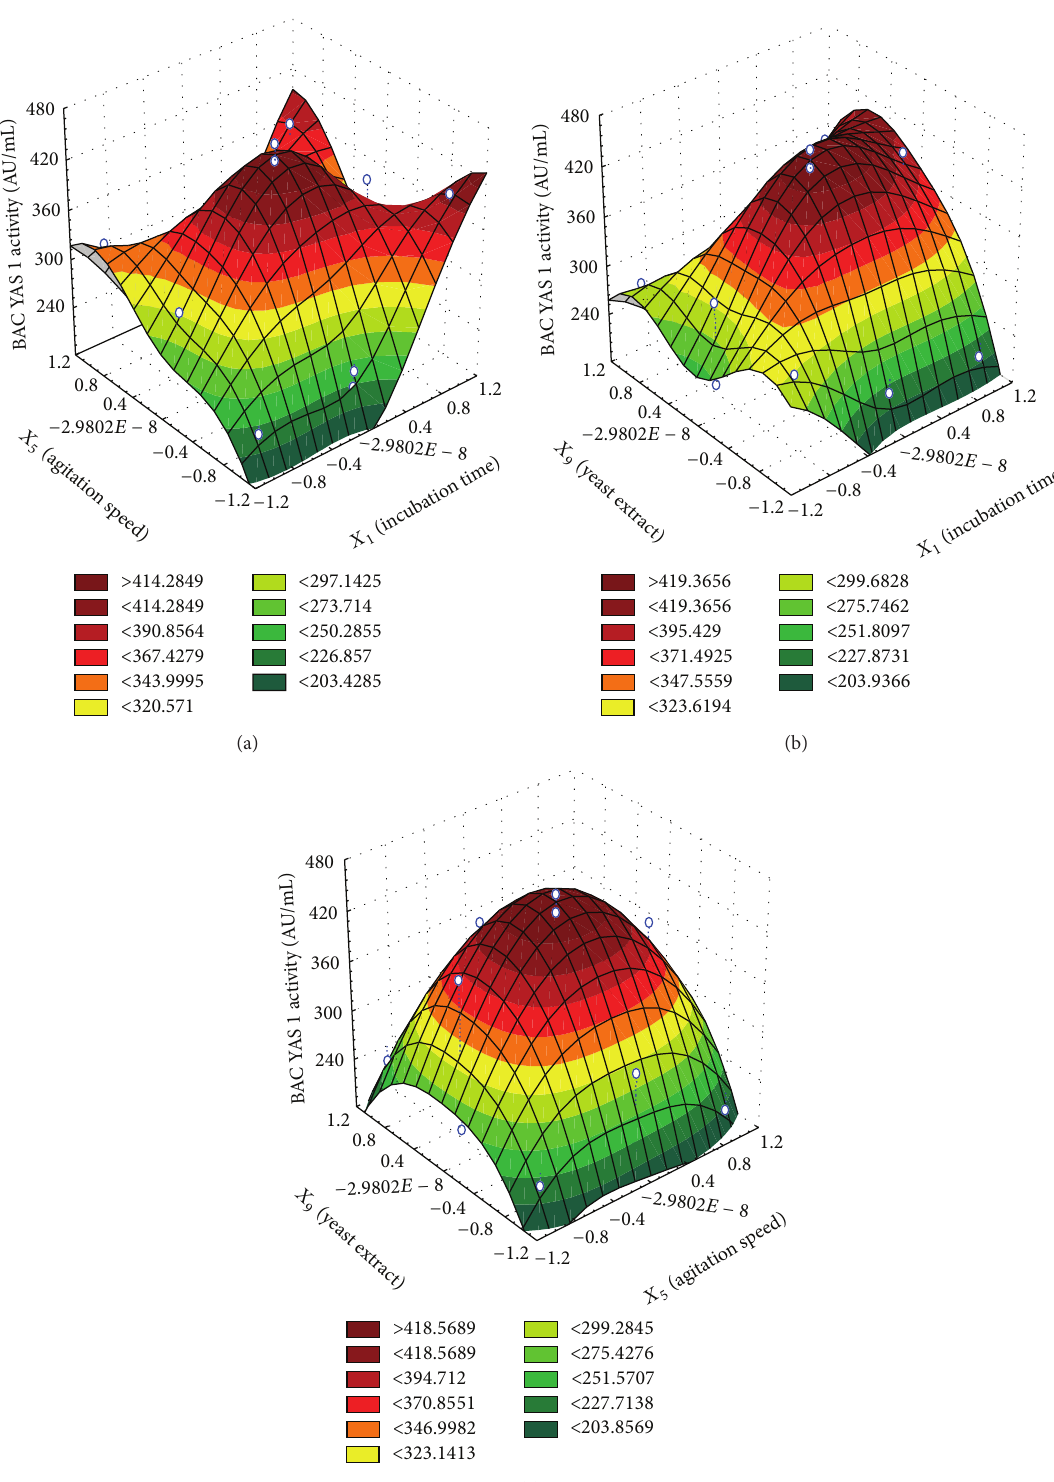
Figure 4: (a) Three-dimensional surface plot for the dependent variable BAC YAS 1 antimicrobial activity versus the independent variables incubation time and agitation speed. (b) Three-dimensional surface plot for the dependent variable BAC YAS 1 antimicrobial activity versus the independent variables incubation time and yeast extract. (c) Three-dimensional surface plot for the dependent variable BAC YAS 1 antimicrobial activity versus the independent variables agitation speed and yeast